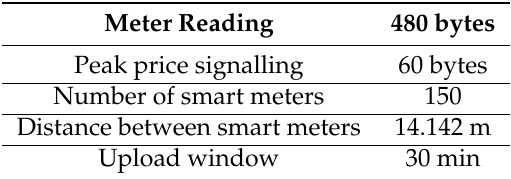
Table 3. Advanced metering infrastructure (AMI)